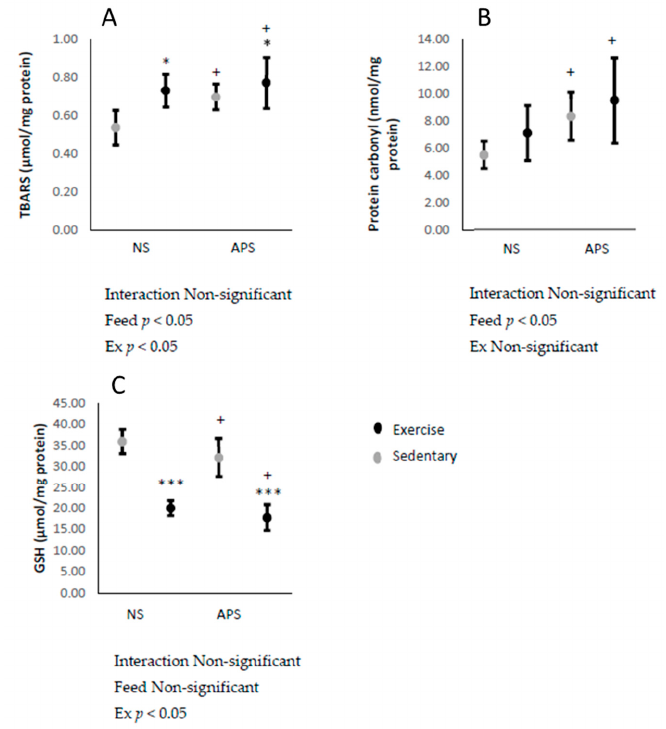
Figure 2. Means ± SEM: ( A ) liver thiobarbituric acid reactive substance (TBARS) (control, n = 6; APS, n = 6; Ex, n = 6; Ex + APS, n = 6), ( B ) protein carbonyl (control, n = 6; APS, n = 6; Ex, n = 6; Ex + APS, n = 6), and ( C ) glutathione (GSH) (control, n = 6; APS, n = 7; Ex, n = 6; Ex + APS, n = 6).